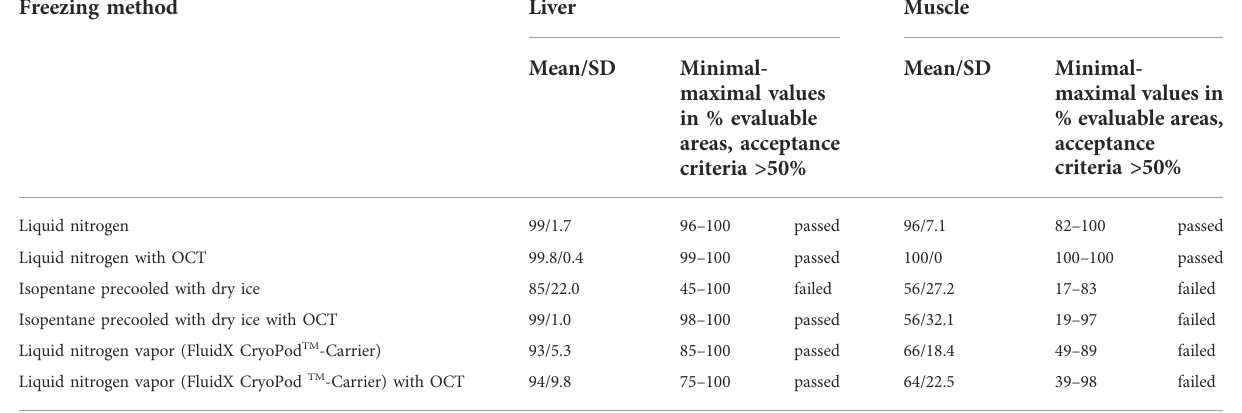
TABLE 2 Optimization: Range of obtained results for evaluable areas in percent per freezing method. Freezing